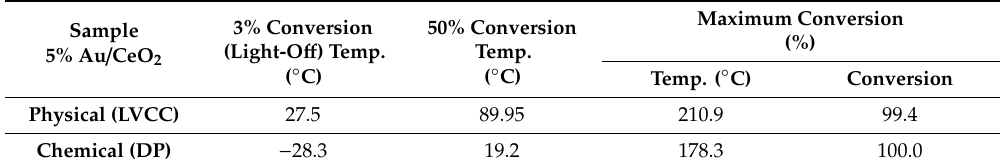
Table 3. Catalytic activities of Au/CeO 2 prepared by LVCC and DP methods after heat treatment in the CO/O 2 mixture (second light-off).